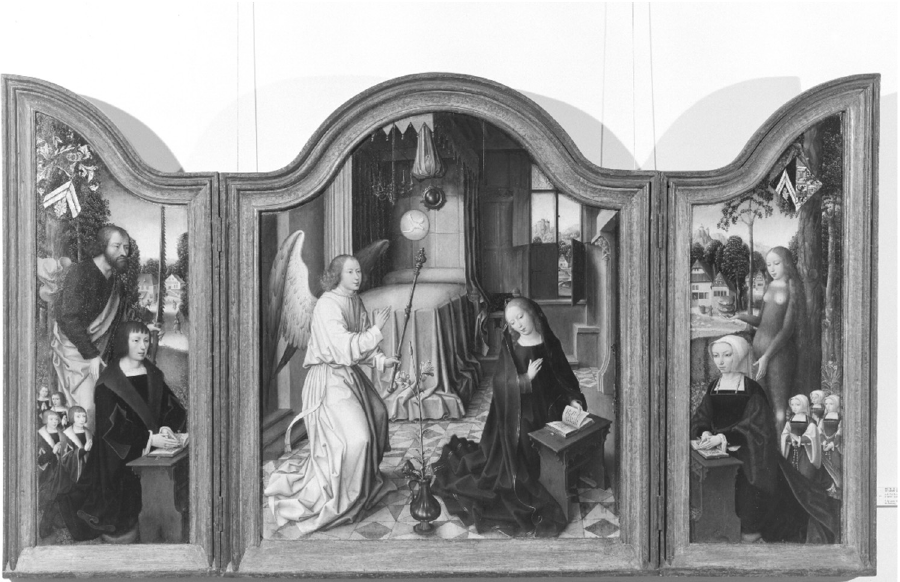
Figure 11. Master of the Legend of the Magdalen, Du Quesnoy-Van der Tommen Triptych , ca. 1515–1520. Oil on panel, 80 × 67.5 cm (centre panel); 81.5 × 28.5 cm (wings). Brussels, Musées Royaux des Beaux-Arts de Belgique. © KIK-IRPA, Brussels (adapted by author).